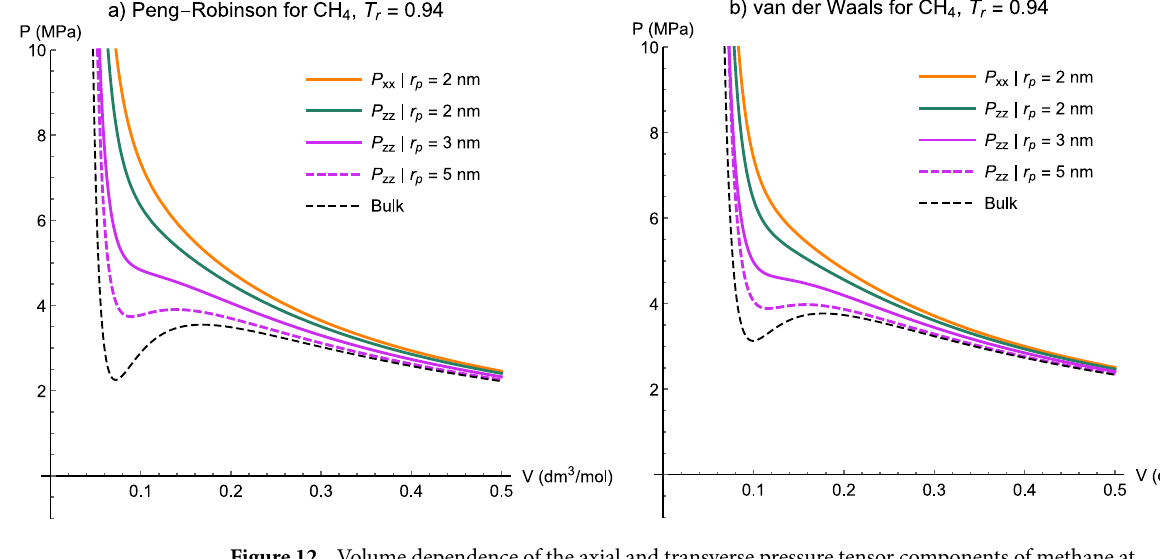
Figure 12. Volume dependence of the axial and transverse pressure tensor components of methane at 0.94 for different r T r p values obtained from ( a ) Peng-Robinson and ( b ) van der Waals equations of state = associated with the Kihara potential function.